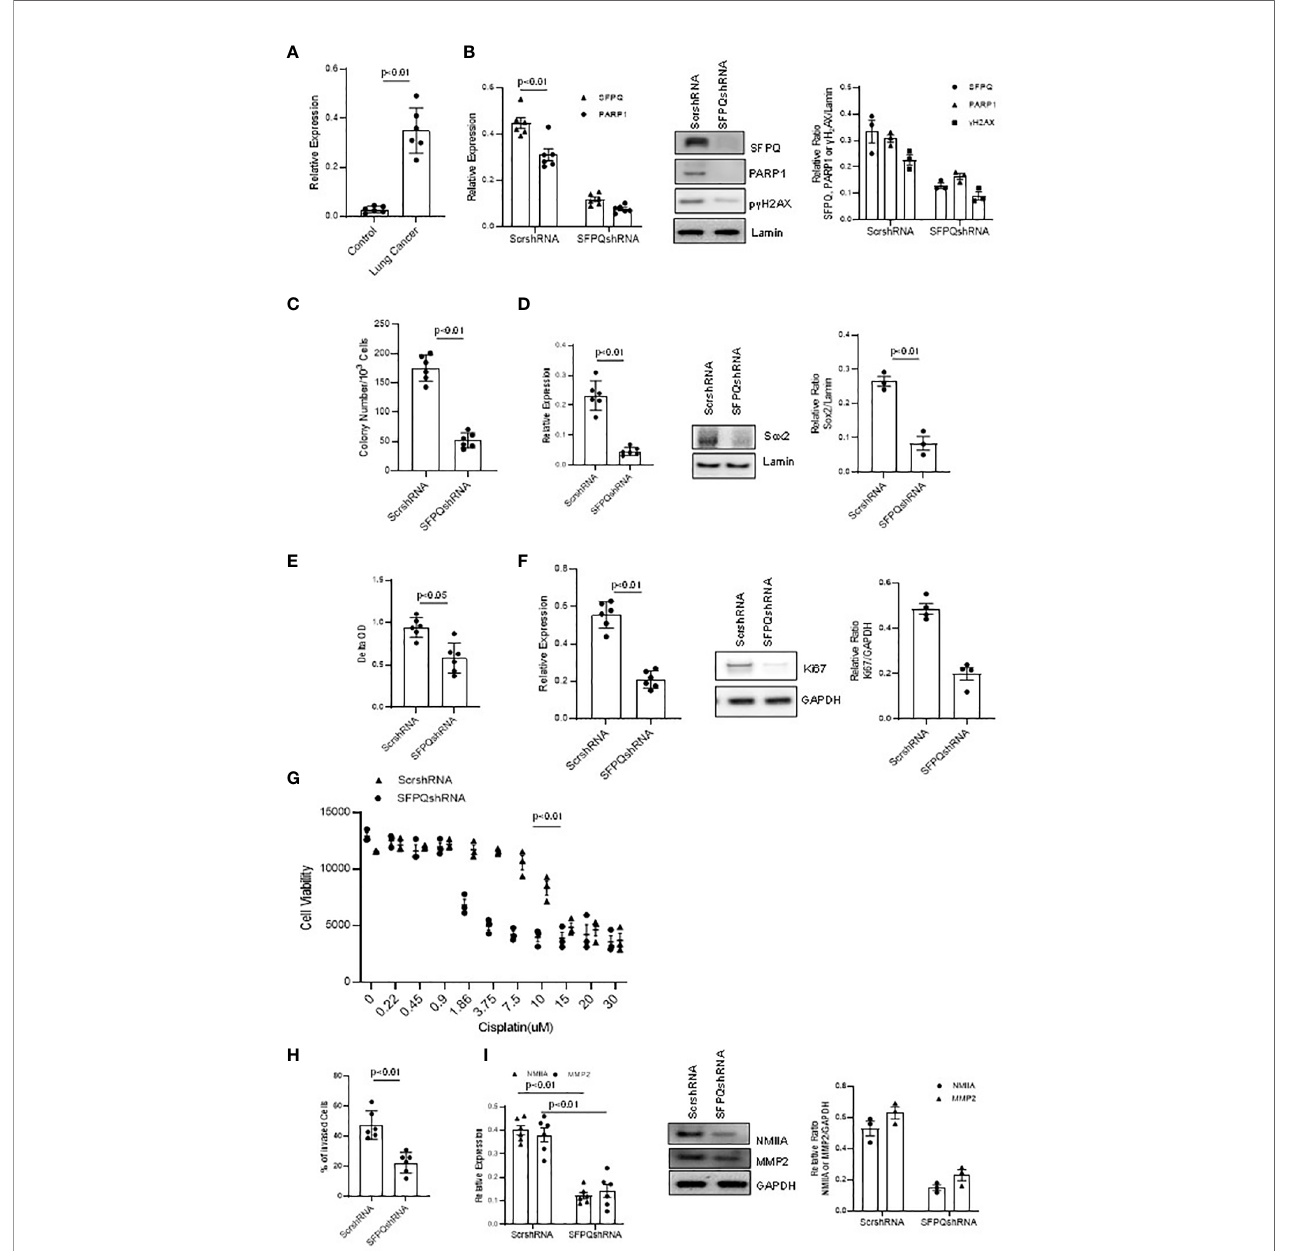
FIGURE 3 | SFPQ is essential for cell stemness, proliferation, and invasion of lung NSC cancer MSCs. Lung NSC cancer MSCs isolated from A549 and Can661 cell lines were transduced with scramble or SFPQ shRNA and 48 hours later the cells were used for following analysis. (A) PARP1 mRNA level was quantitatively analyzed with RT-PCR in control and lung NSC cancer MSCs (far left: cell Con210, Con205, Con249; NSC cancer cell lines, Can661, Can838 and A549). (B) DNA damage marker H2AX was reduced in PARP1 knockdown lung cancer MSCs. g H 2 AX and PARP1 mRNA level in RT-PCR (left) and protein levels were analyzed with western blot analysis (middle). Densitometry analysis of WB were shown in the right graph. (C) Colony Formation Assay of lung cancer MSCs. Colony number was accounted microscopically from 6 random fi elds/well. Colony number was reduced in lung cancer MSCs transduced with SFPQ shRNA. (D) Sox2 expression in lung NSC cancer MSCs was quanti fi ed with RT-PCR (left panel) and western Blot analysis (middle panel). Densitometry analysis of WB are shown in the right graph. (E) Cell Proliferation assay. Lung cancer MSC proliferation was inhibited when SFPQ expression was knocked down with SFPQ shRNA. (F) Ki67 levels in lung cancer MSCs were analyzed with RT-PCR (Left) and western blot analysis (Middle). Densitometry values are shown in the right graph. (G) IC50 assay for Cisplatin. Dose responses of cisplatin were plotted as the percent of MTS staining vs. untreated cells from three replicate experiments. Lung NSC Cancer MSCs transduced with SFPQ shRNA were more sensitive to Cisplatin than the control group. (H) Cell invasion assay. Bars represent the total number of invading cells from 6 random fi elds/well. Invasive capacity of lung NSC cancer MSCs was decreased after SFPQ knockdown. (I) NMIIA and MMP2 expression in lung NSC cancer MSCs were quanti fi ed with RT-PCR (Left) and western blot analysis (Middle). Densitometry values are shown in the right hand graph. All data are shown as mean ± S.E. ( n =3 independent